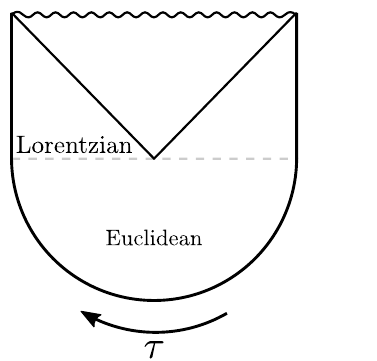
Figure 15 . A pictorial representation of the Euclidean shell geometry of eq. (B.9).